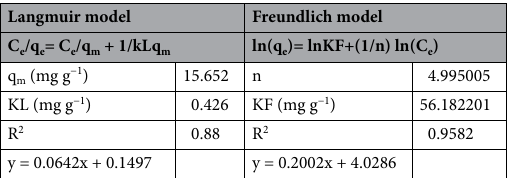
Table 1. Isotherm parameters for MB adsorption onto PAK at 298 K.